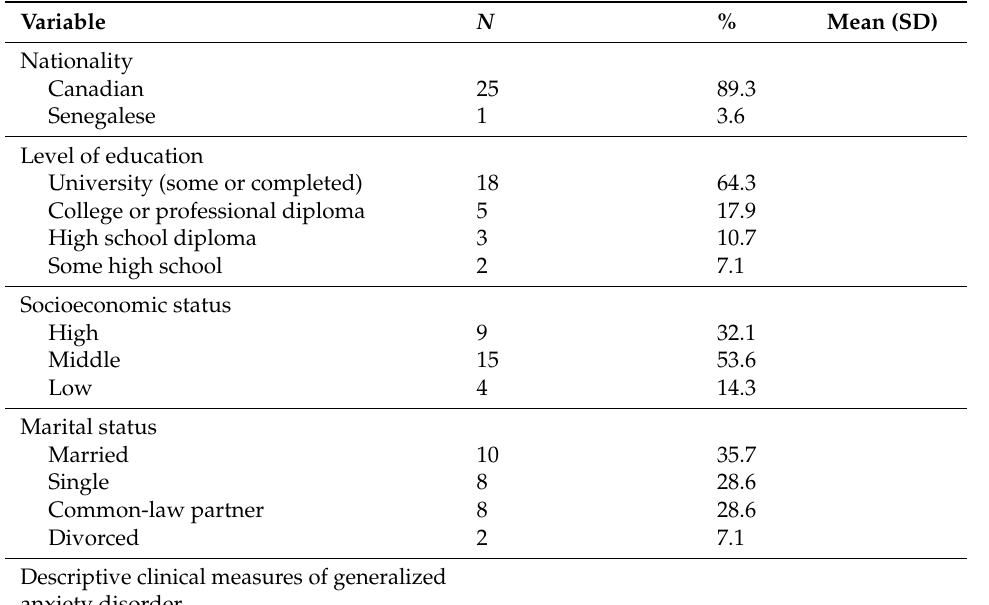
Table 1. General description of the